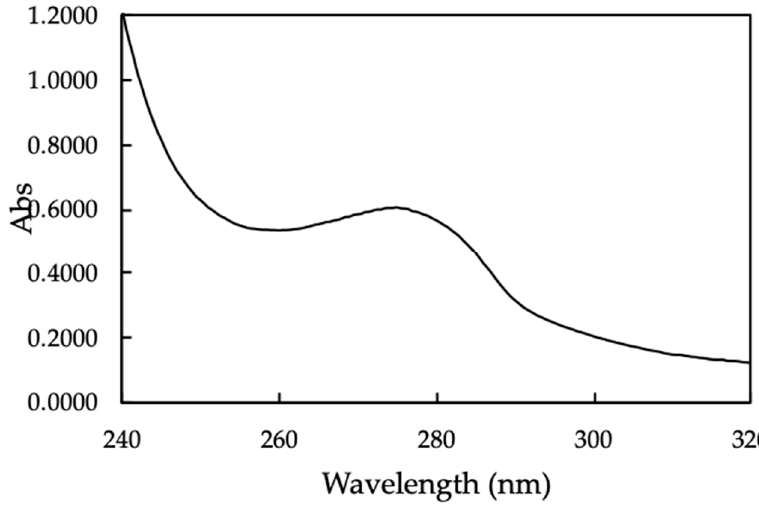
Figure 3. The UV-Vis spectrum of Moringa (MO) seeds protein.